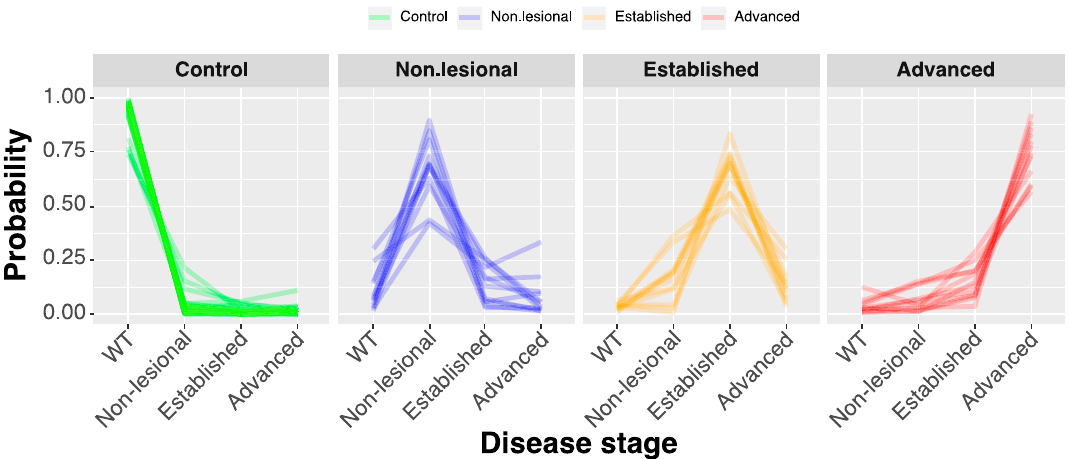
Figure 6. Classification of samples into disease progression groups. Parallel plot illustrating the classification of individual samples by elastic net regression. Each line represents a sample, and the highest point in the line corresponds to the group where the sample would be classified with higher probability.